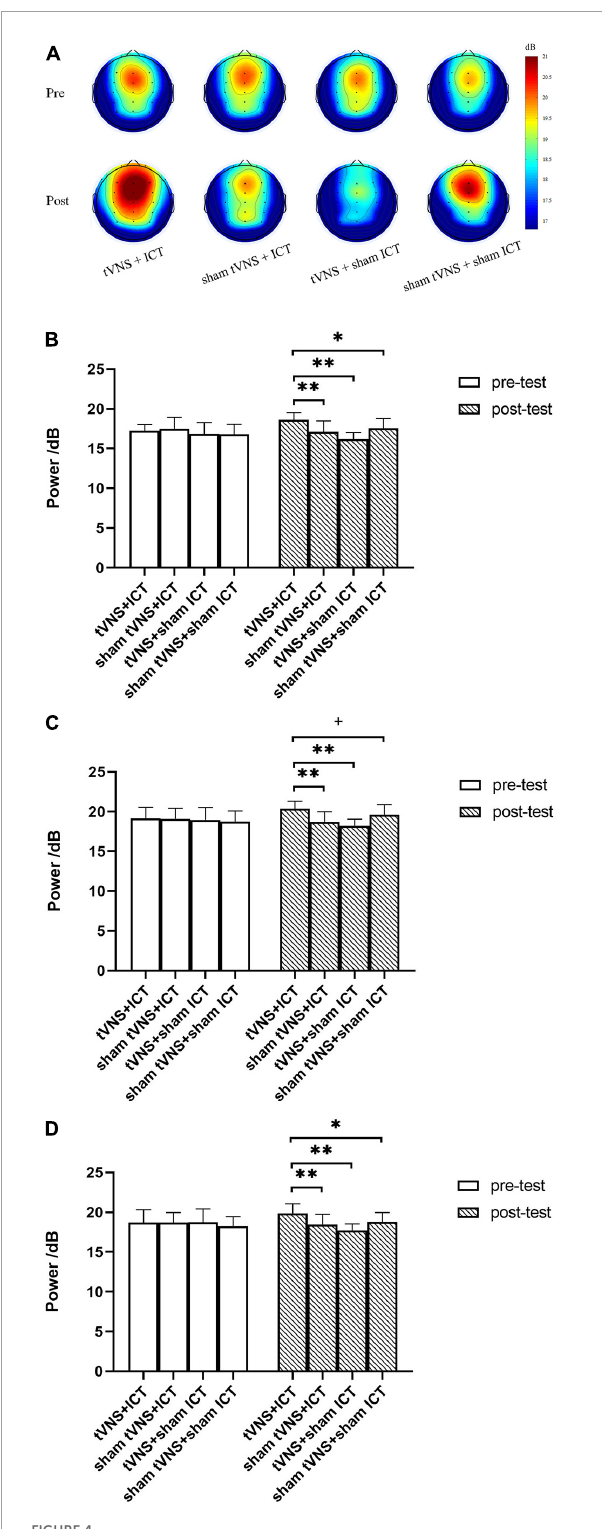
FIGURE4 Summary of alpha power in SST. (A) Topography of alpha power spectrum density between the four groups during pre- and post-test phases. (B) Alpha power between groups, during pre- and post-test phases in frontal region. (C) Alpha power between groups, during pre- and post-test phases in fronto-central region. (D) Alpha power between groups, during pre- and post-test phases in central region. Error bars represent the standard deviation of the mean. ∗∗ p < 0.01, ∗ p < 0.05, + p <